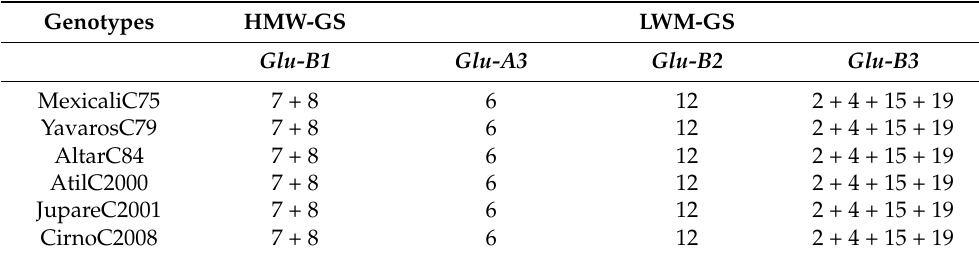
Table 6. List of genotypes with their high- and low molecular weight glutenin subunit composition as determined by SDS-polyacrylamide gel electrophoresis.